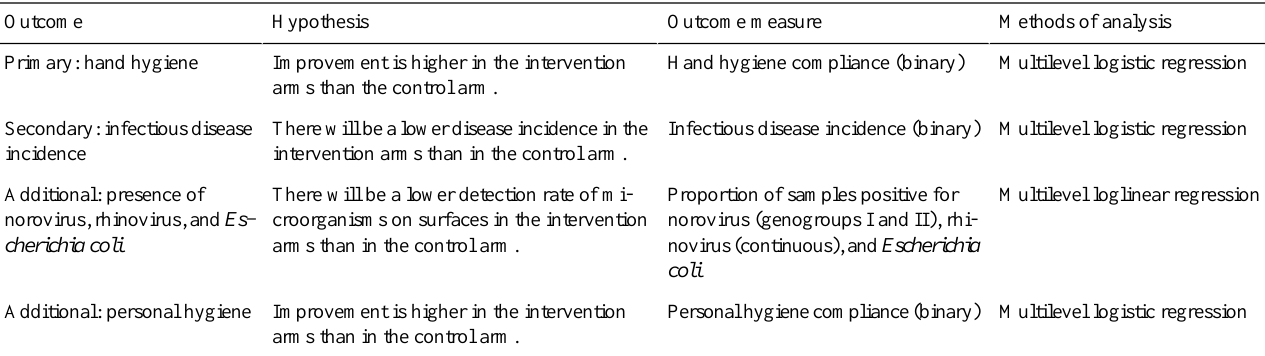
Table 4. Statistical